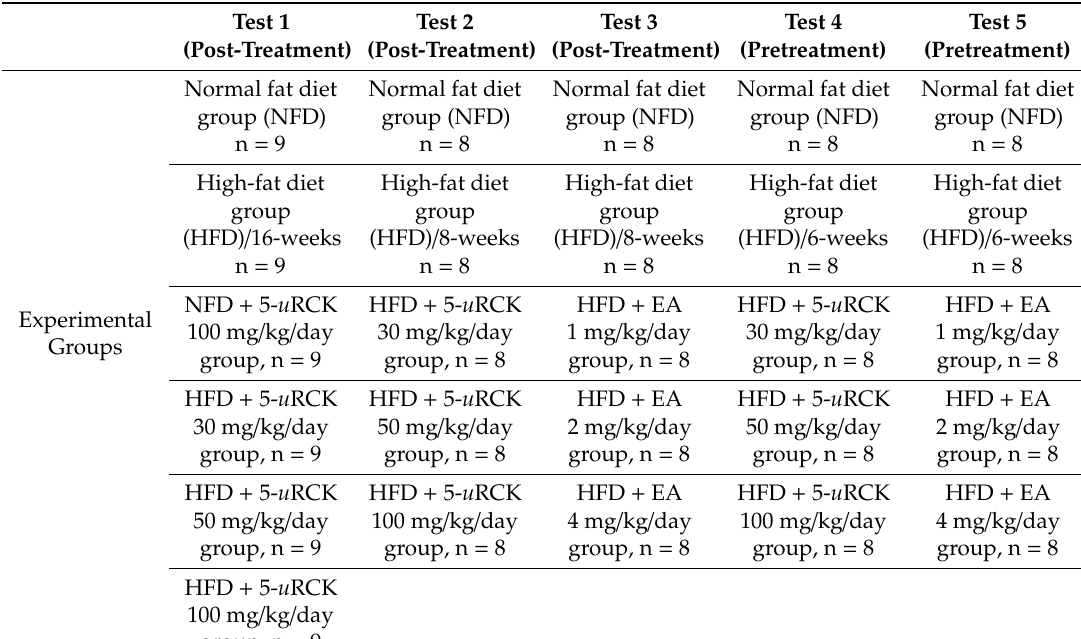
Table 5. Experimental group